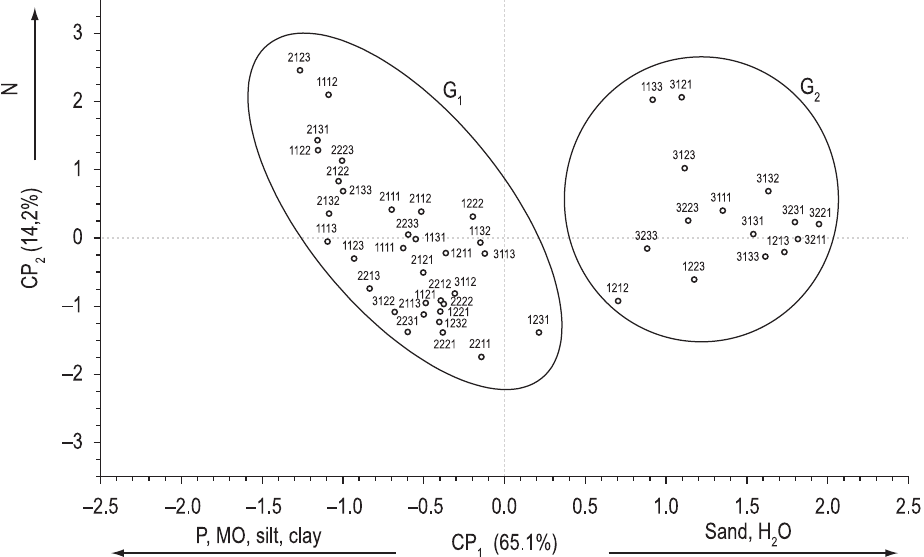
Figure 2. Sampling site arrangement according to principal components CP Camargo (1), Coqueiral (2), and Cavalos (3). Lakes; the second, the dry (1) and rainy (2) sampling periods; the third, the transect (1, 2, and 3) and the fourth, the position in the transect, 1 limnetic – littoral, 2- intermediate, and 3, littoral – terrestrial zones; the arrows indicate the direction in which the original variables increase within each principal component; G1 and G2 are the groups shaped by the ordination analysis).